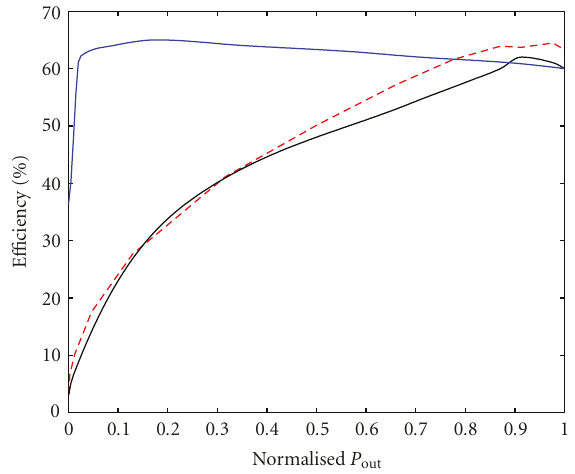
Figure 8: E ffi ciency against power output. PWM curves are for V dd = 30V (solid) and for V = 10V (dashed) and EER (solid). dd